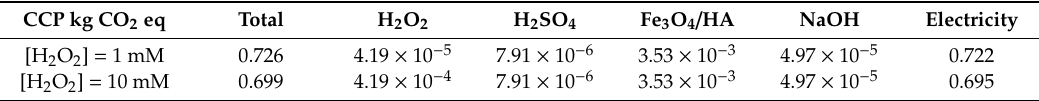
Table 6. Comparison of the climate change potential (kg CO 2 eq) results of the degradation process of 90% of 20 µ M BPA in 1 L of water in the presence of 1mM and 10 mM of H 2 O 2 activated by Fe 3 O 4 / HA (100 mg / L) at pH